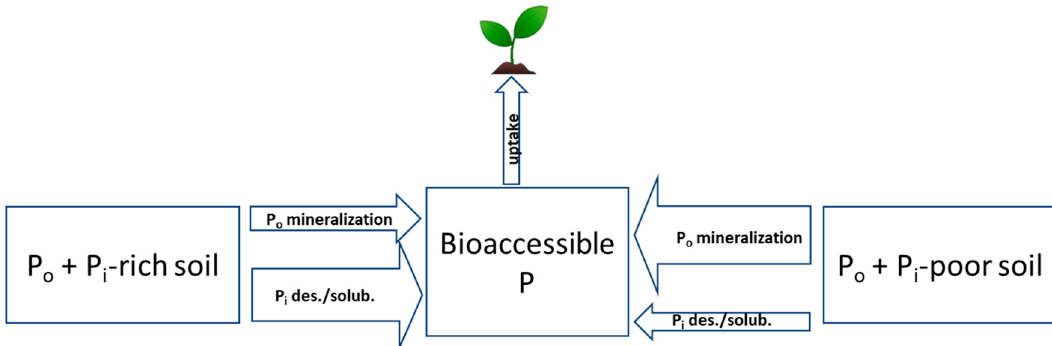
Figure 3. Conceptual representation of organic and inorganic P transformations towards releasing dissolved P and their expected magnitude of occurrence when legacy P is higher and largely dominated by bioaccessible inorganic P (P o + P i -rich soil) versus when legacy P is lower and deficient of bioaccessible inorganic P (P o + P i -poor soil), assuming equal concentrations of organic P. Arrow size indicates the relative magnitude of fluxes . Legend: P o , soil organic P; P i , soil inorganic P; and des/solub, desorption and dissolution.